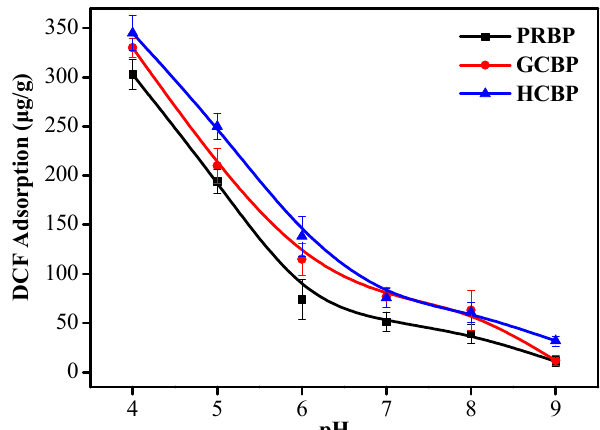
Figure 5. Effect of pH on the adsorption of DCF onto PRBP, GCBP, and HCBP. Experimental conditions: m = 2 g/L, C 0 = 5 mg/L, T = 25 ± 1 °C.